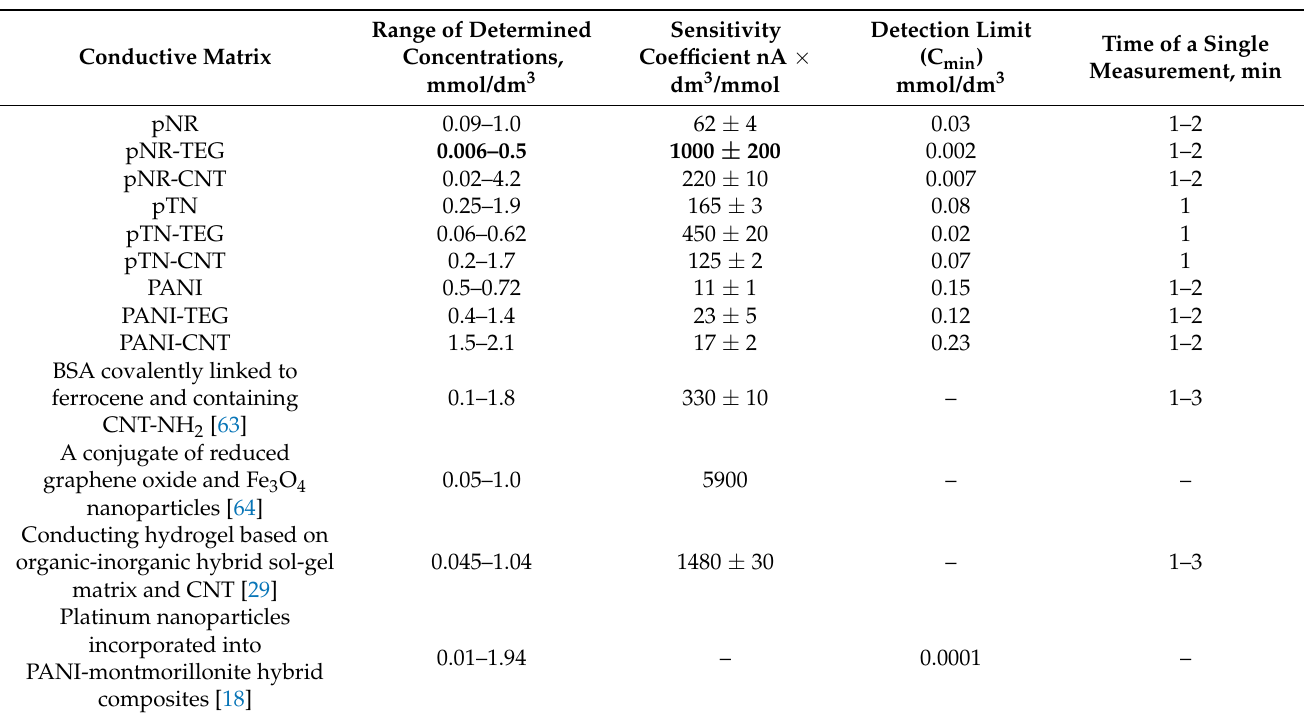
Table 2. Main characteristics of biosensors based on the developed modified printed electrodes and analogues.